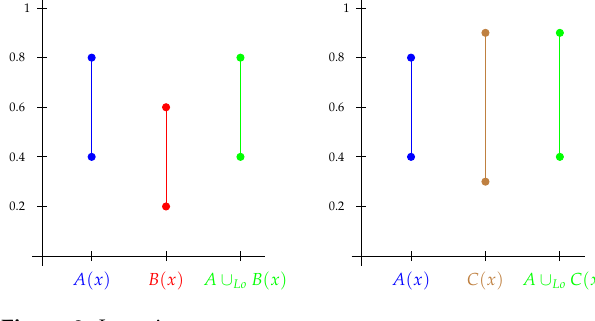
Figure 9. Lo -union.